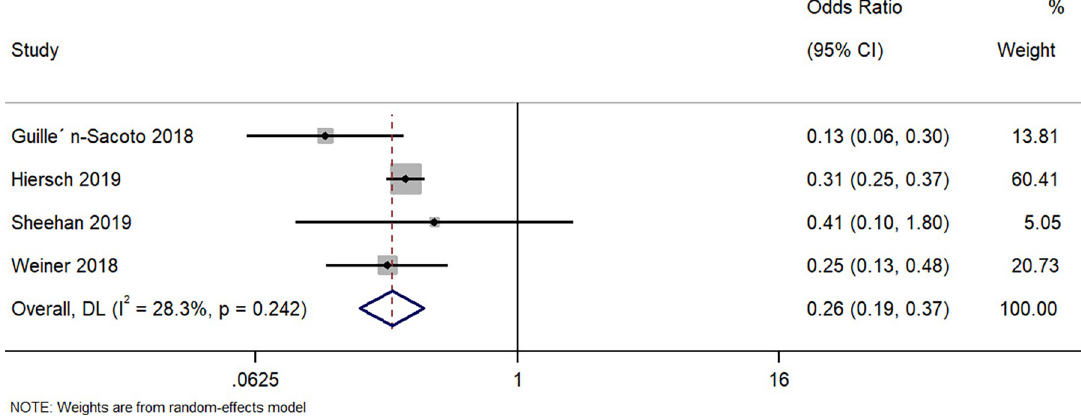
Fig 7. Forest plot showing the difference in respiratory morbidity in neonates between women with a singleton pregnancy or twin pregnancy and GDM. NOTE: Weights are from random-effects model.